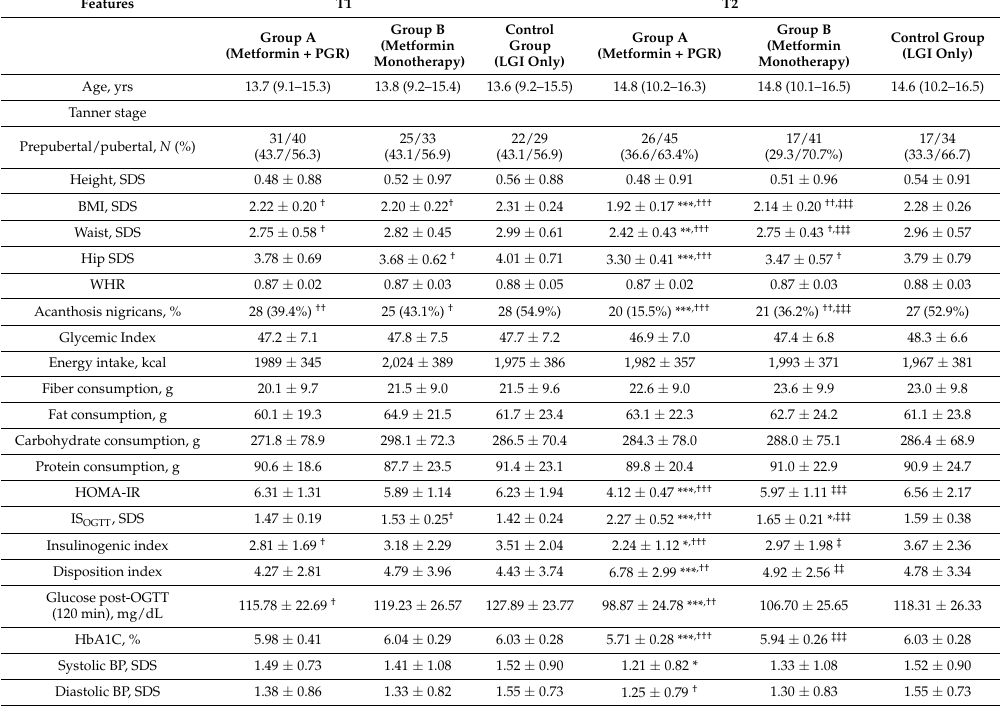
Table 2. Anthropometric, clinical and biochemical differences during treatment with metformin or metformin plus Policaptil gel retard and in control